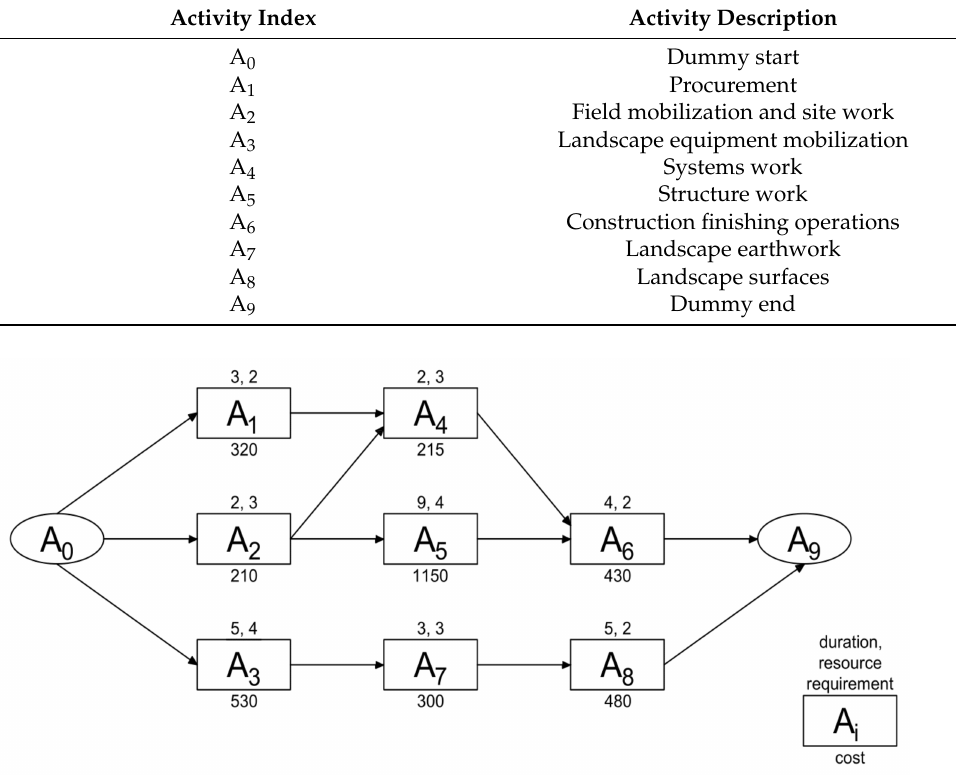
Table 5. Activity list for the problem instance.